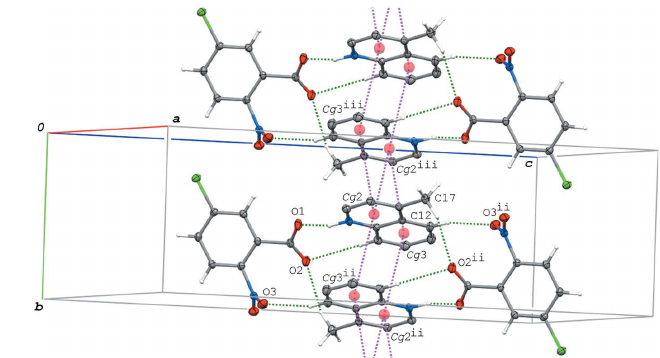
Figure 11 A packing diagram of (VI), showing the ribbon structure formed via the (cid:2) – (cid:2) interactions (magenta dashed lines), and the N—H (cid:2)(cid:2)(cid:2) O and C— H (cid:2)(cid:2)(cid:2) O hydrogen bonds (green dashed lines). H atoms not involved in the hydrogen bonds are omitted for clarity. Cg 2 and Cg 3 are the centroids of the N2/C8–C11/C16 and C11–C16 rings, respectively. [Symmetry codes: (ii) (cid:3) x + 3 , (cid:3) y + 3 , (cid:3) z + 1; (iii) (cid:3) x + 3 , (cid:3) y + 1 , (cid:3) z + 2 2 2 2